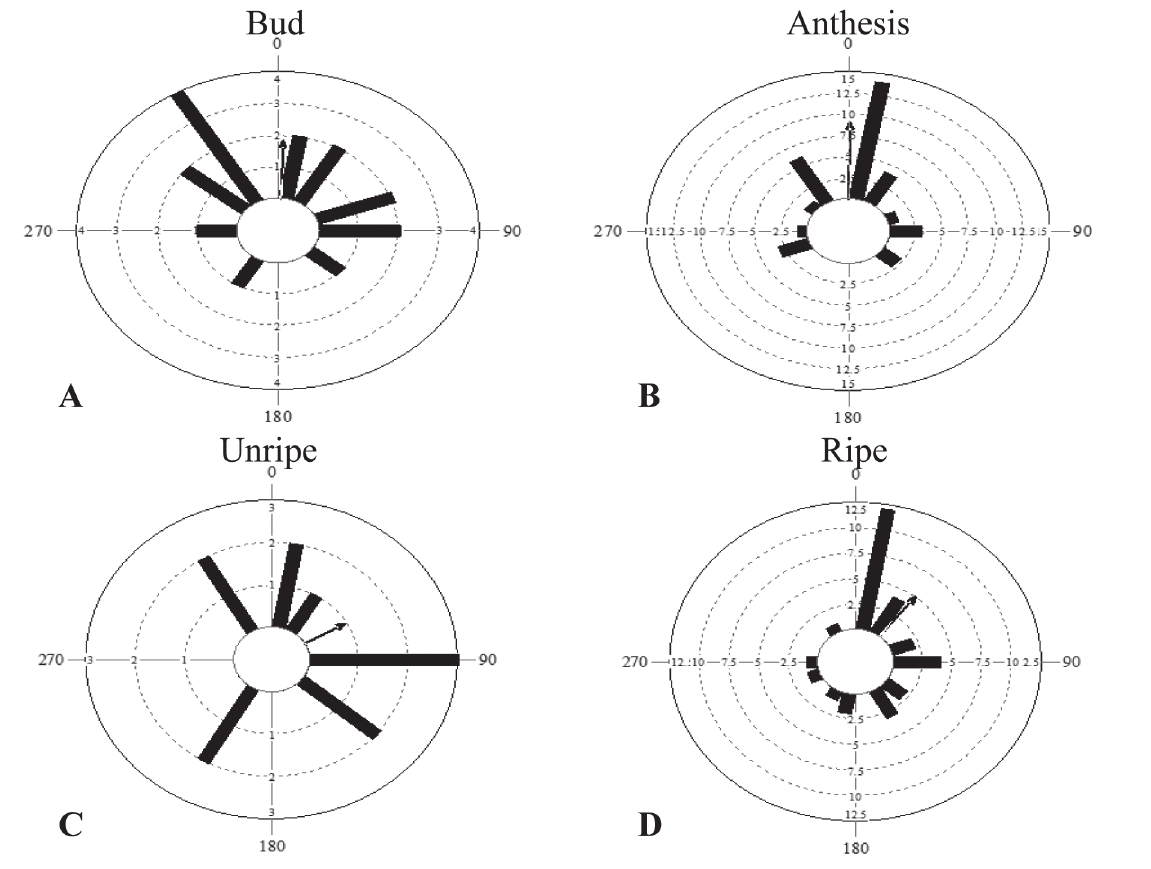
Fig. 2 - Circular histograms at monthly intervals of species in each phenophase of flowering divided into floral buds and open flowers (A, B) and of fruiting divided into unripe and ripe fruits (C, D) . The arrow indicates the average date of phenophase occurrence; the vector length indicates the species concentration around this